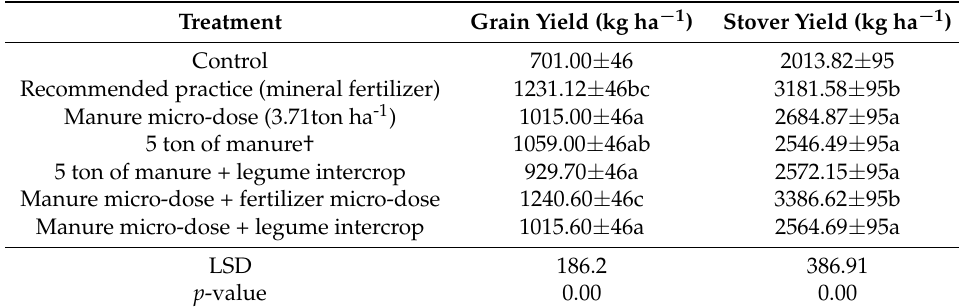
Table 5. Yield responses of maize for manuring in Borana, southern